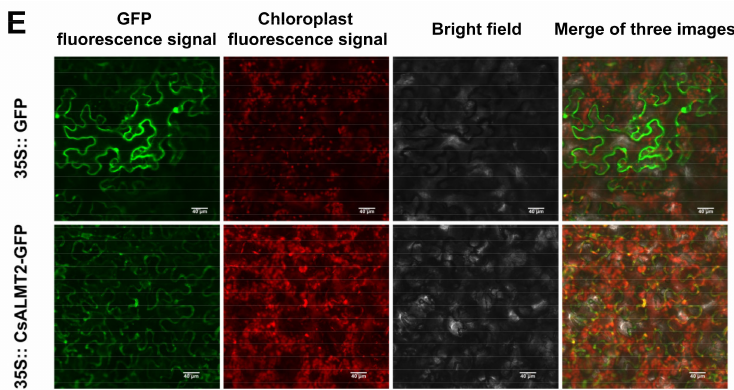
Figure 6. Fluorescence in situ hybridization analysis and subcellular localization in CsALMT2 : ( A , B ) Images of H6 fruit at 0 d under a 1 × and 30 × fluorescence microscope, respectively; ( C , D ) images of H7 fruit at 0 d under a 1 × and 30 × fluorescence microscope, respectively. Blue light represents the nucleus, red light is the positive expression of fluorescein labeling. Yellow arrows represent positive expression of CsALMT2 . ( E ) subcellular localization of CsALMT2 in tobacco